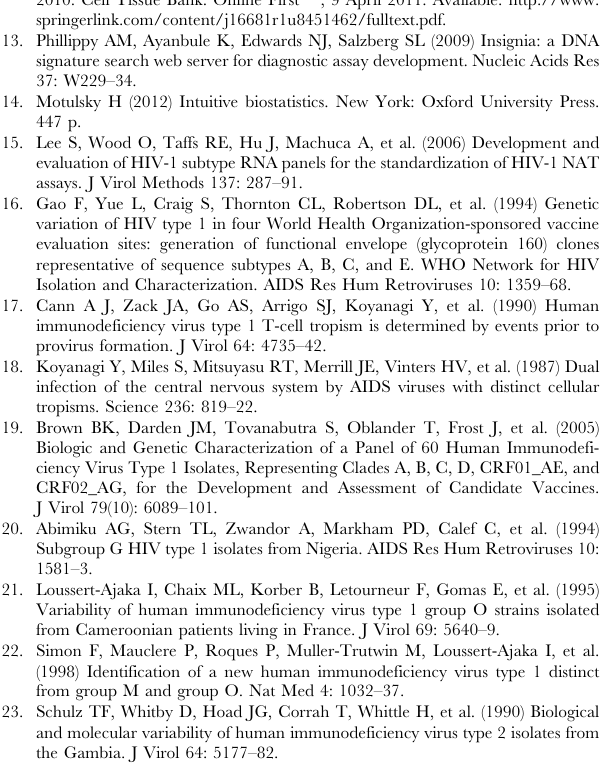
Figure S1 Standard and melting curves generated for HIV-1 specific primer set NP3/4 using analytical DNA standards. Serial dilutions of HIV-1 DNA standards (5 to 10 4 genome copies, shown in red) spiked into 50 ng of human DNA were run in four experimental repeats each. A. Amplification curve. B. Standard curve. C. Melting curve. HIV-1 positive cells (20 ng of total DNA) are shown in black, no-template control (NTC) – in light blue, ‘‘negative’’ human DNA control – in green. The limit of sensitivity of this primer set determined in the experiment was 10 genome copies/PCR. Figure S2 Real-time PCR viral array design. Primer names (shown in bold), melting peaks of melting temperature (Tm) (bold italic) and PCR product size (underlined) are indicated in each well of 96-well plate image. The color scheme, shown on the right, refers to each virus.